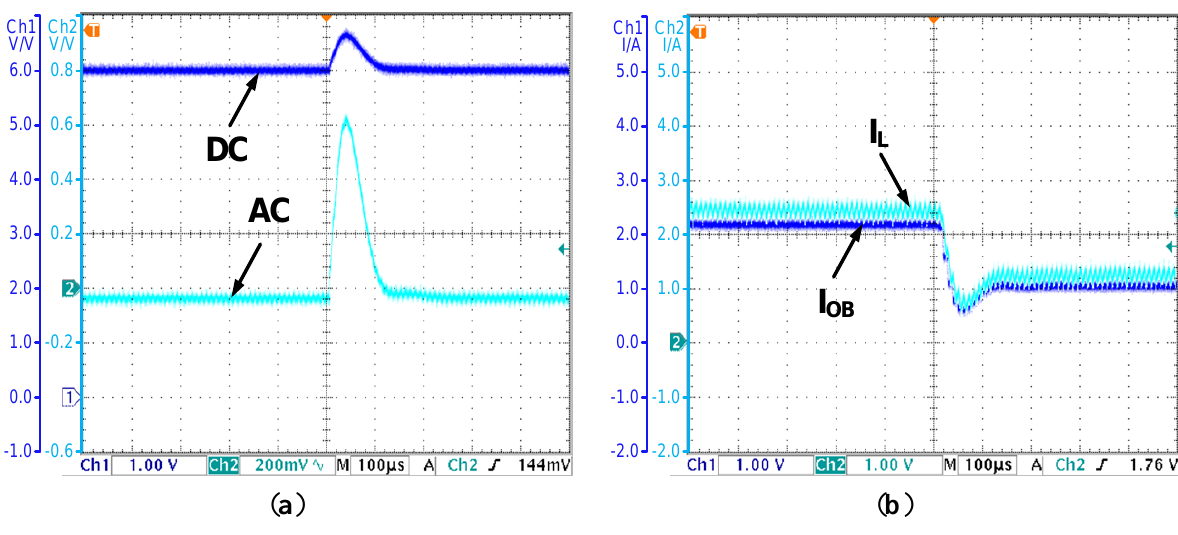
Figure 11. ( a ) The output voltage transient when the load steps from 3 Ω to 5 Ω—the OCO based PCC controlled converter; ( b ) The observed current and the inductor